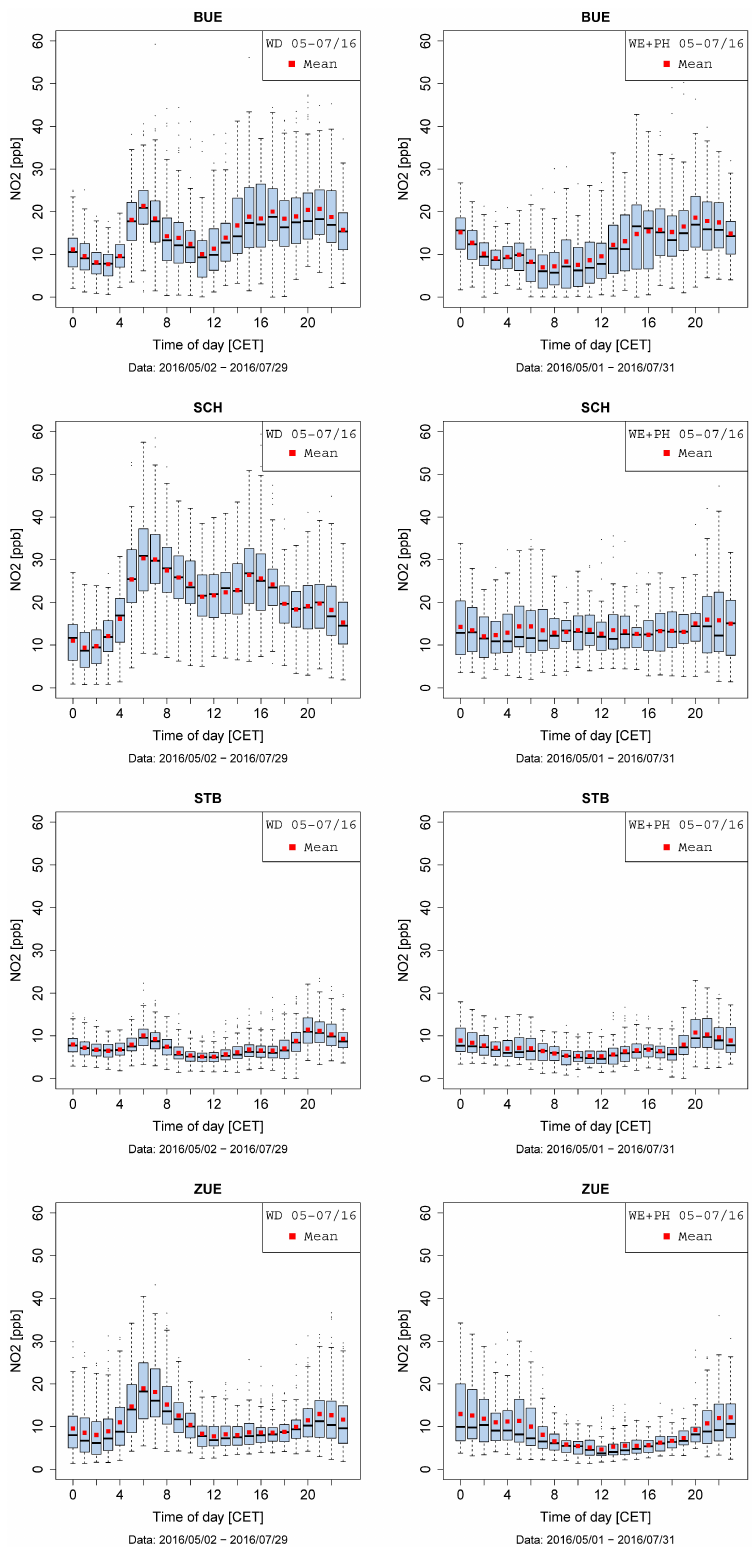
Figure 11. Comparison of the diurnal variation of NO 2 concentration at two AQM sites (SCH and ZUE) and at two sensor network locations (BUE and STB, data from DS 3). The left-hand figures depict data from working days (WD), the right-hand figures data from weekends and public holidays (WE + PH). Sites RGS and BUE are roadside locations, sites STB and ZUE are background